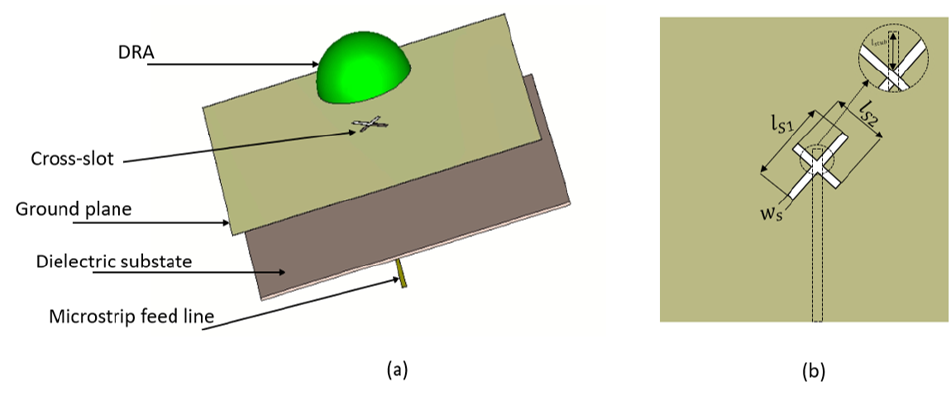
Figure 2. Antenna configuration ( a ) 3D view ( b ) Feed